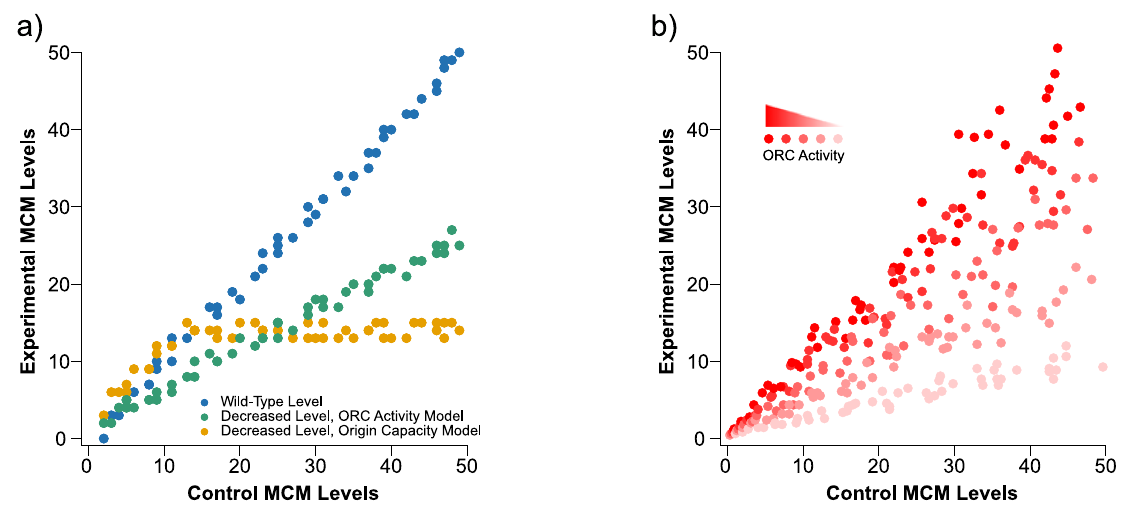
Fig 7. Models for how changes in the cellular levels of MCM affect their loading dynamics at origins of replication and replication timing. a) Expected results if an ORC Activity model or an Origin Capacity model governs how MCM is distributed genome-wide. b) A combined model shows that, if there is a range of ORC activities and origin capacities, in normal cells ORC activity has little effect and MCM loading is largely determined by origin capacity because neither time nor MCM abundance are limiting. However, when MCM abundance becomes limiting, ORC activity becomes important because origins with more active ORC can load MCM